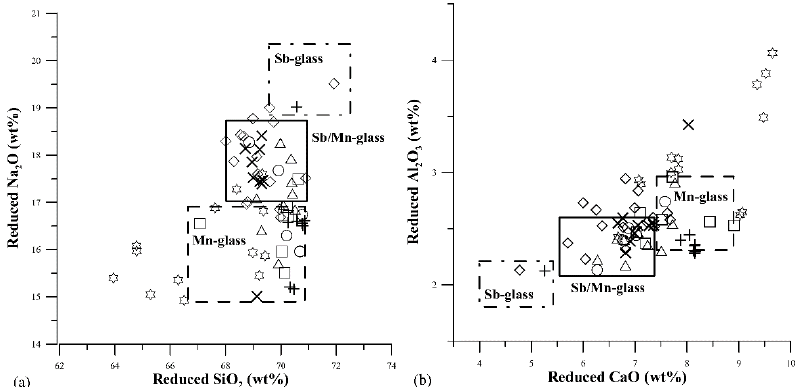
Figure 2. Reduced Na 2 O versus SiO 2 ( a ) and reduced Al 2 O 3 versus CaO ( b ) contents of Pordenone and Trento tesserae, subdivided by color macro-group: colorless ( ), turquoise ( ♢ ), blue (□), white ( ○ ), yellow ( △ ), green ( ), red ( ). Compositional ranges of literature groups (Sb-glass; Sb/Mn glass; Mn- glass) calculated from raw data published in Silvestri [40], Silvestri et al. [41], Gallo et al. [42] and Maltoni et al. [43].